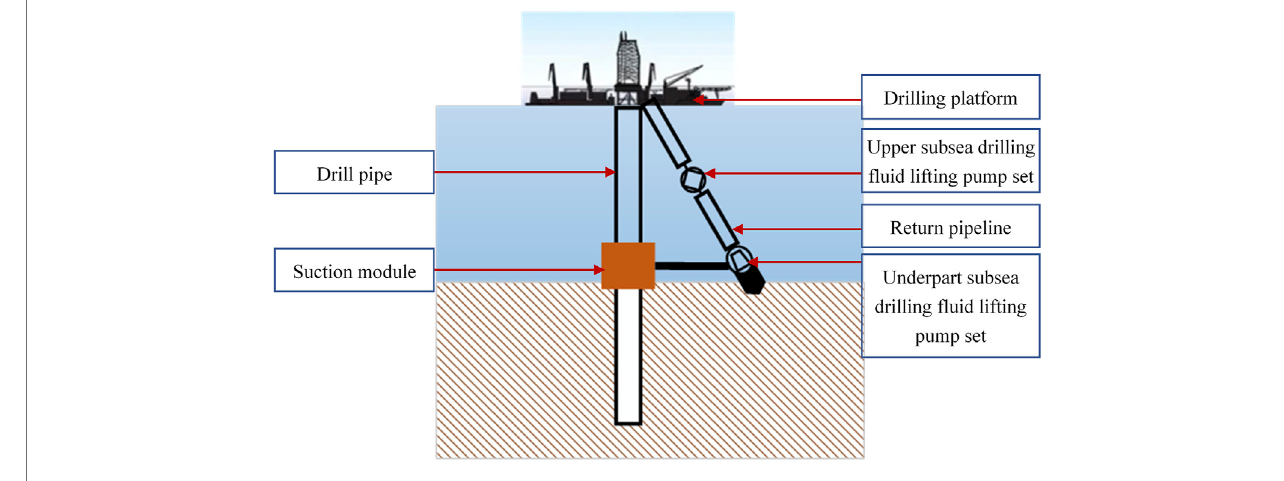
FIGURE 1 | Deepwater RMR system.